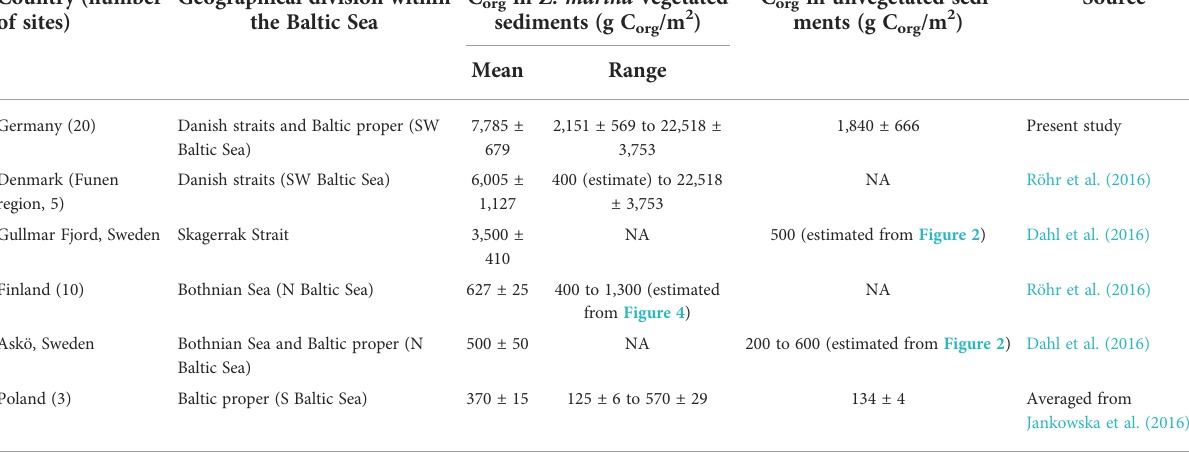
TABLE 5 Spatial heterogeneity (average, min, max) of C org (g C org /m 2 ) in the upper 25 cm sediments of Zostera marina -vegetated and unvegetated sublocations of the Baltic Sea. Country (number of